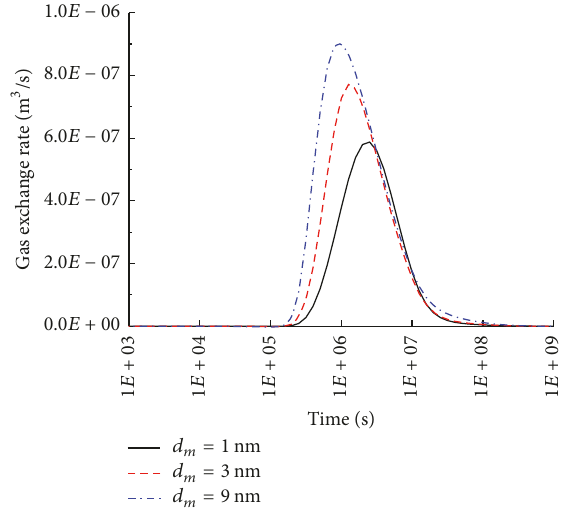
Figure 18: Variation of gas exchange rate with time at different pore